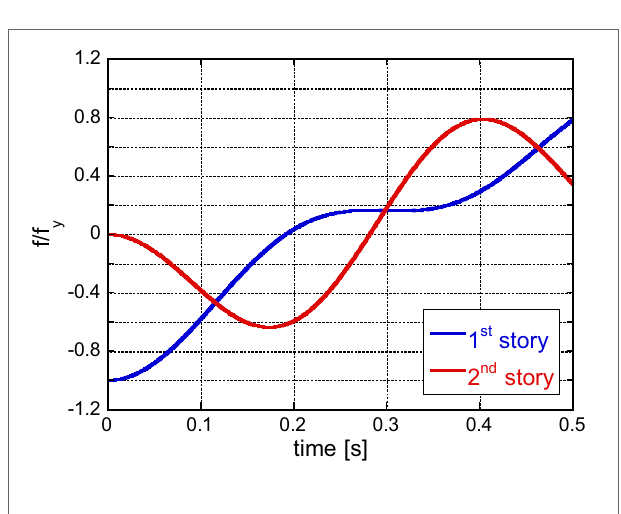
FigUre 20 | Time histories of the restoring forces in the first and second stories starting from the phase (a).